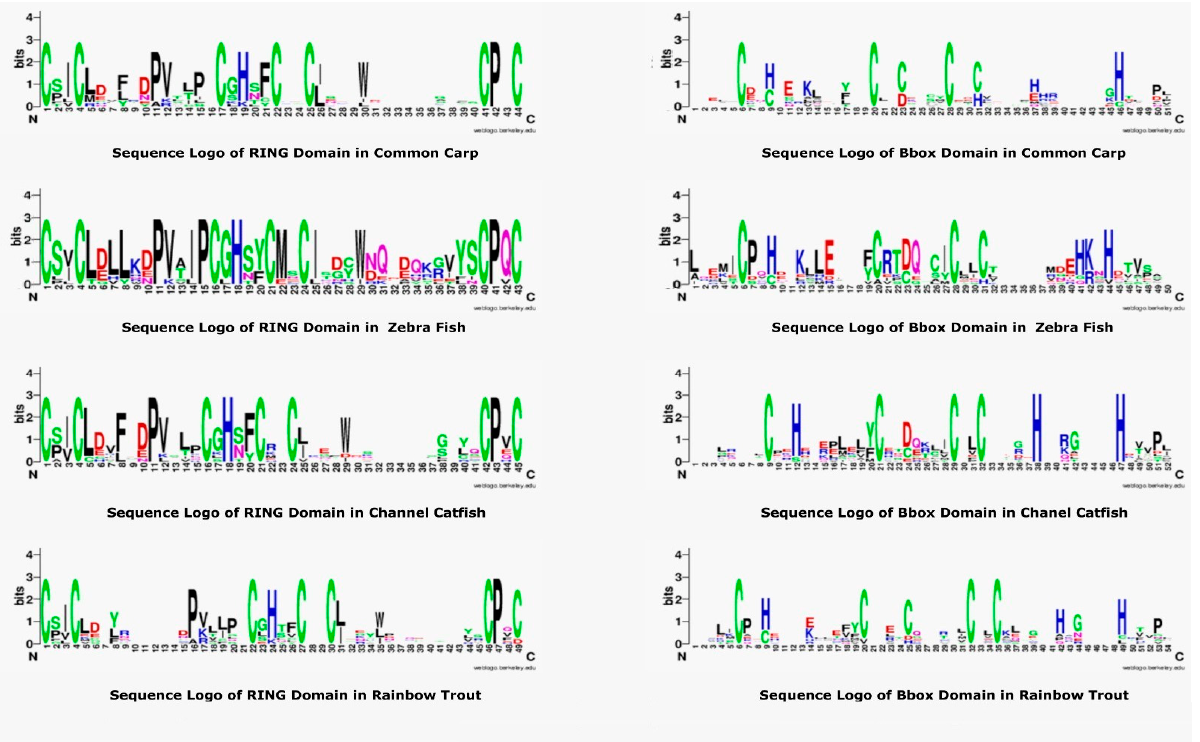
Figure 5. Sequence Logo representation of common carp, zebrafish, channel catfish, and rainbow trout of RING and B-box domain sequences from TRIM proteins. In each logo, the X -axis indicates the conserved amino acids displayed with one letter and specific color. The height indicates the relative frequency of amino acids at that position. The sequence logos of these domains were constructed by using the Weblogo